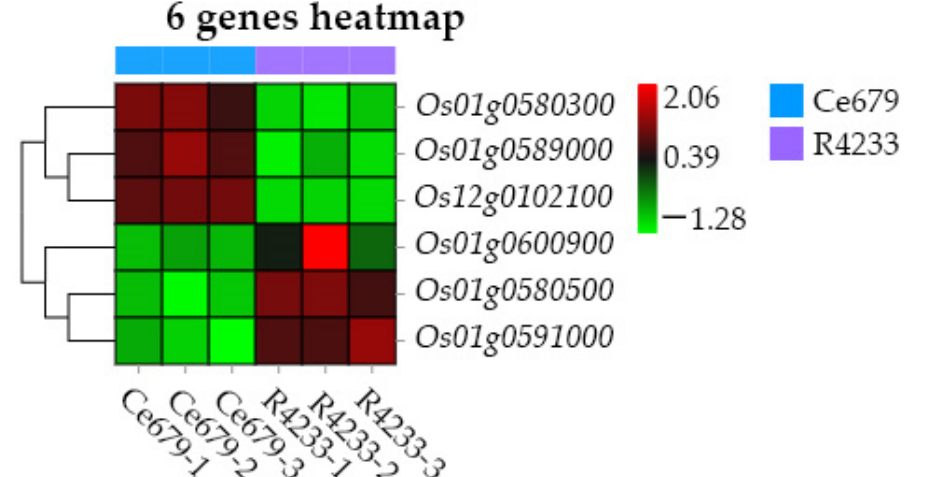
Figure 12. The co-expression network analysis of DEGs and DEMs between Ce679 and R4233 in young panicle.